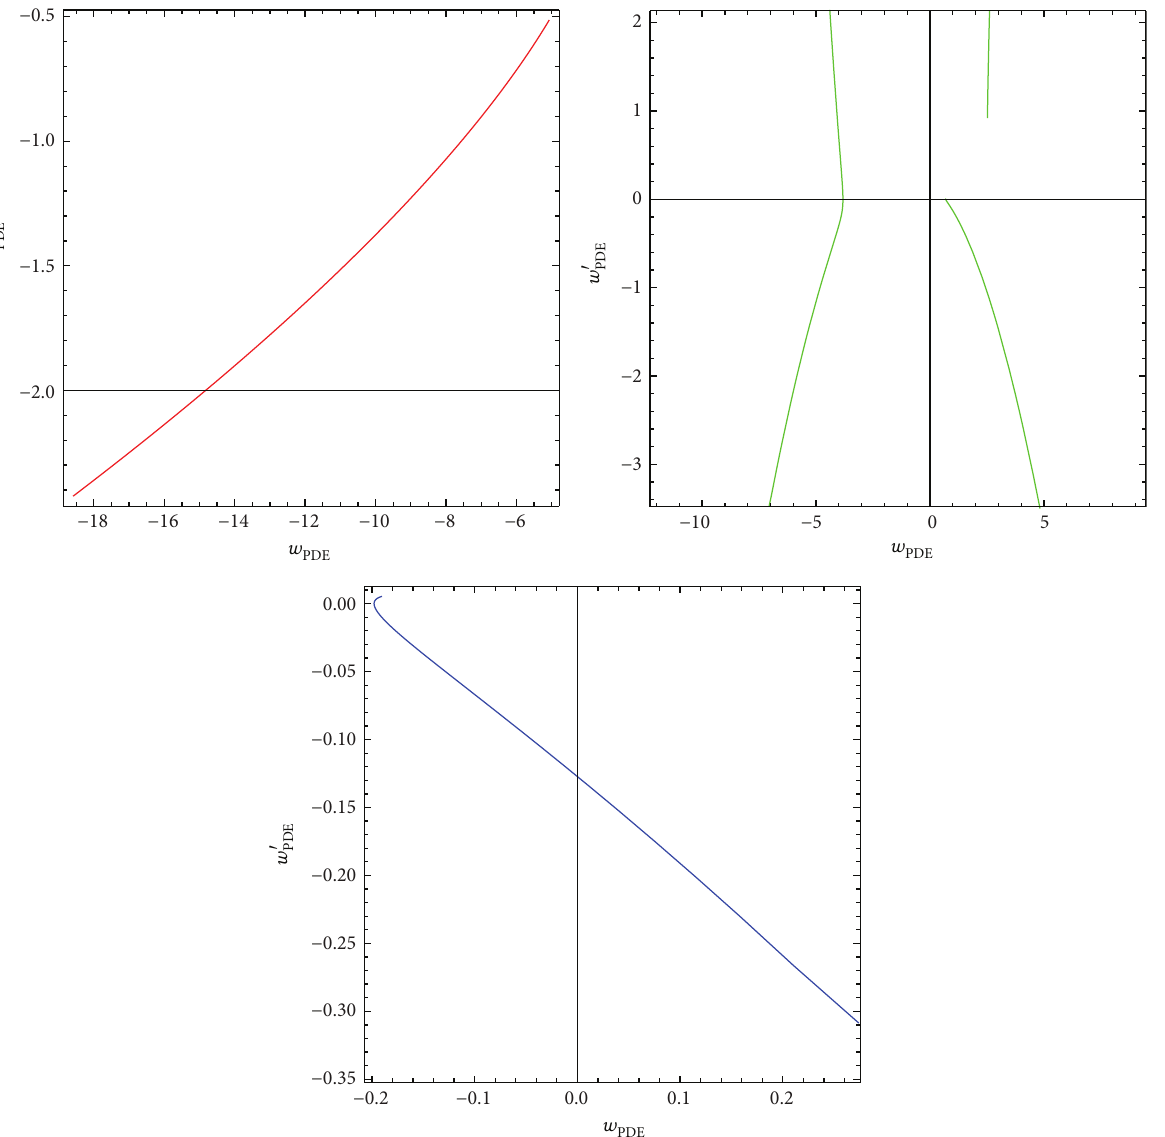
Figure 7: Trajectories of 𝑤 - 𝑤 󸀠 for reconstructed PDE 𝑓(𝐺) model for 𝑢 = 2 with 𝑚 = 2 (red), 𝑚 = 2.2 (green), and 𝑚 = 2.4 PDE PDE